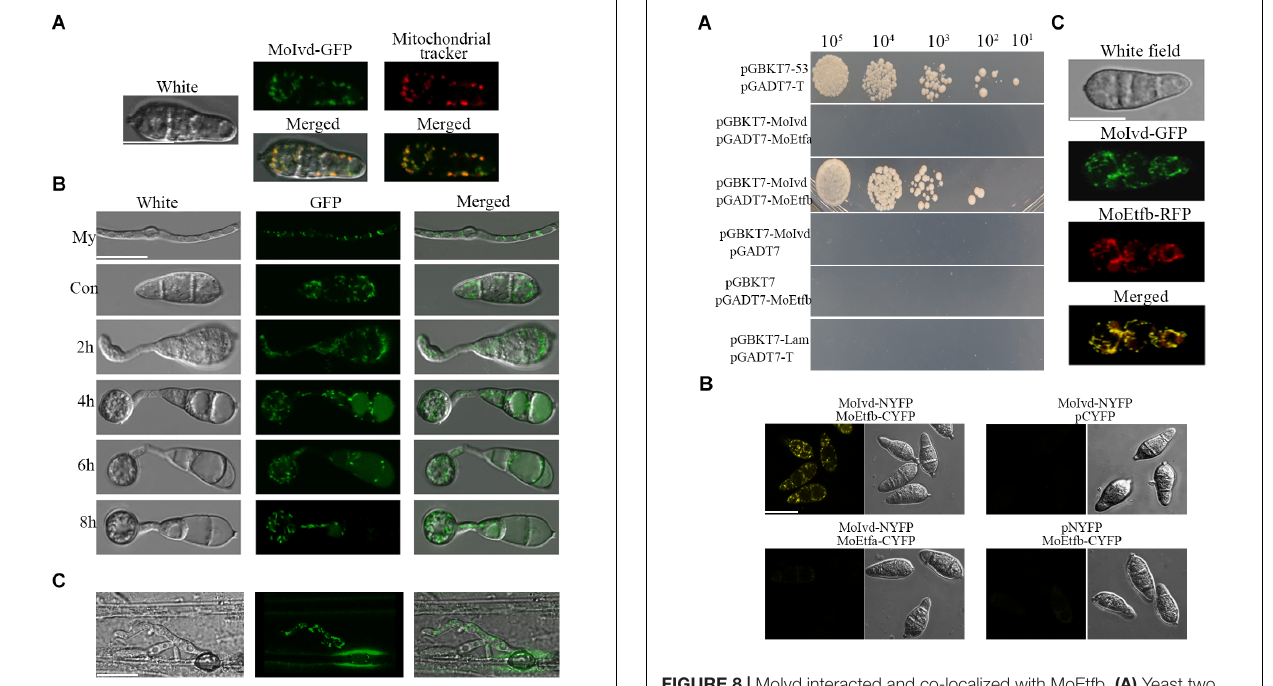
FIGURE 8 | MoIvd interacted and co-localized with MoEtfb. (A) Yeast two hybrids showing that MoIvd interacted with MoEtfb, but not MoEtfa. The yeast transformants were grown on -His/-Ade/-Trp/-Leu/SD medium with 2 mM 3AT to test the interaction. (B) BIFC showing that MoIvd interacted with MoEtfb by displaying whole yellow signal in conidia transformed with MoIvd-NYFP and MoEtfb-CYFP. Bar = 10 µ m. (C) MoIvd-GFP was co-localized with MoEtfb-RFP by showing overlapping GFP and RFP fluorescence in conidia transformed with MoIvd-GFP and MoEtfb-RFP. Bar = 10 µ